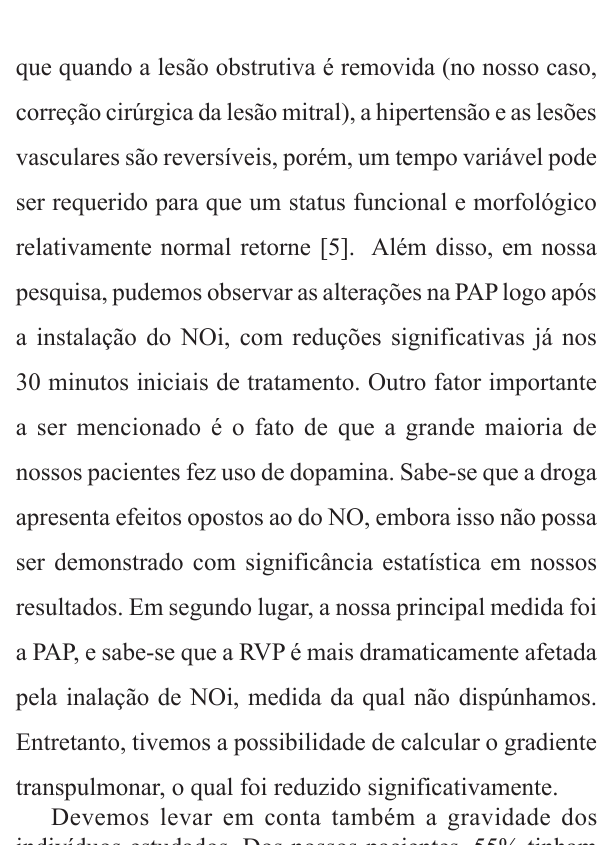
1. Lopes AAB, Soraggi AMB, Ebaid M. Hipertensão